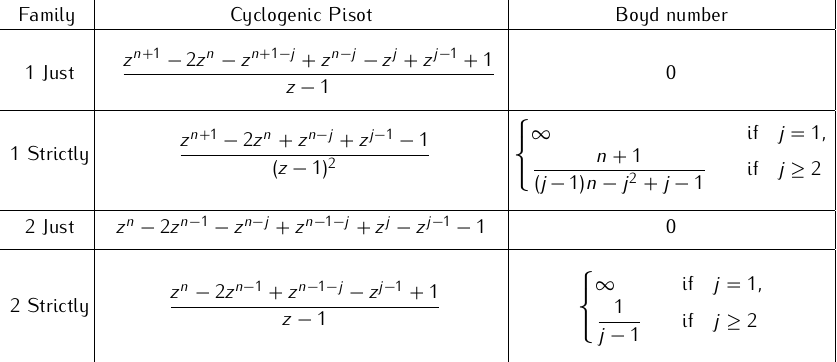
Table 4. The cyclogenic Pisot polynomials associated via Theorem 4.3 to the two infinite families of interlacing cyclotomic pairs given in Table 1. Family Cyclogenic Pisot Boyd